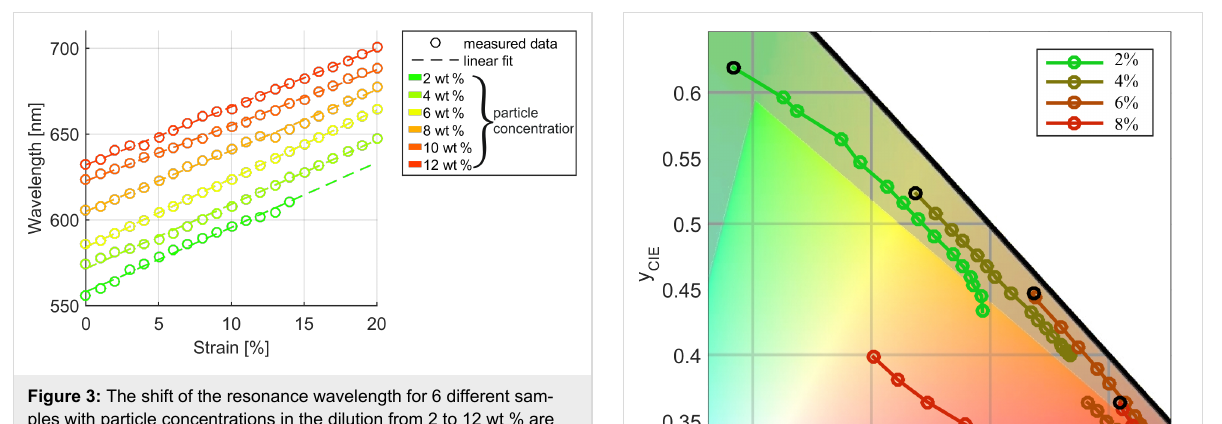
ment points from 15 to 20% could not be acquired because the sample ruptured at 15%. In this sample, air bubbles were above 15%.